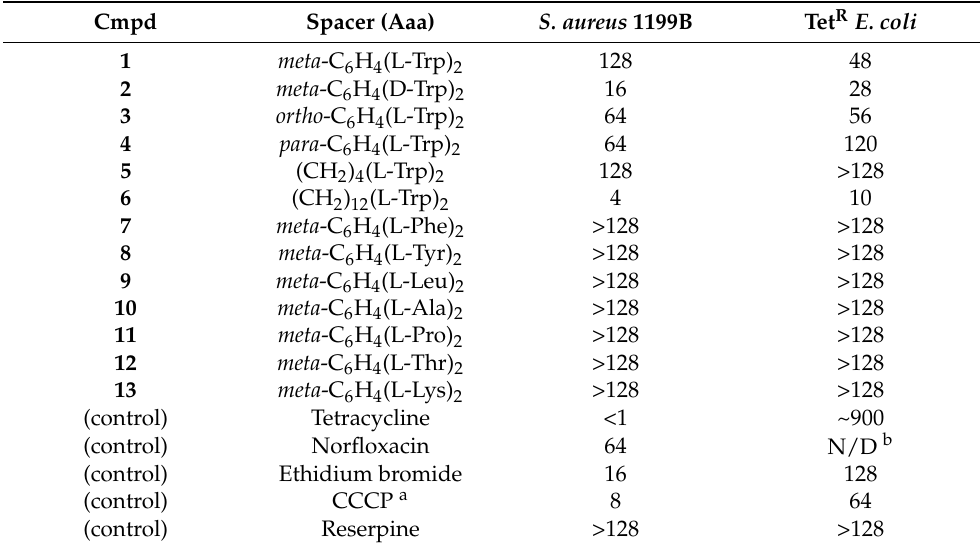
Table 1. Minimum Inhibitory Concentrations ( µ M) of Compounds 1 – 13 and Controls.